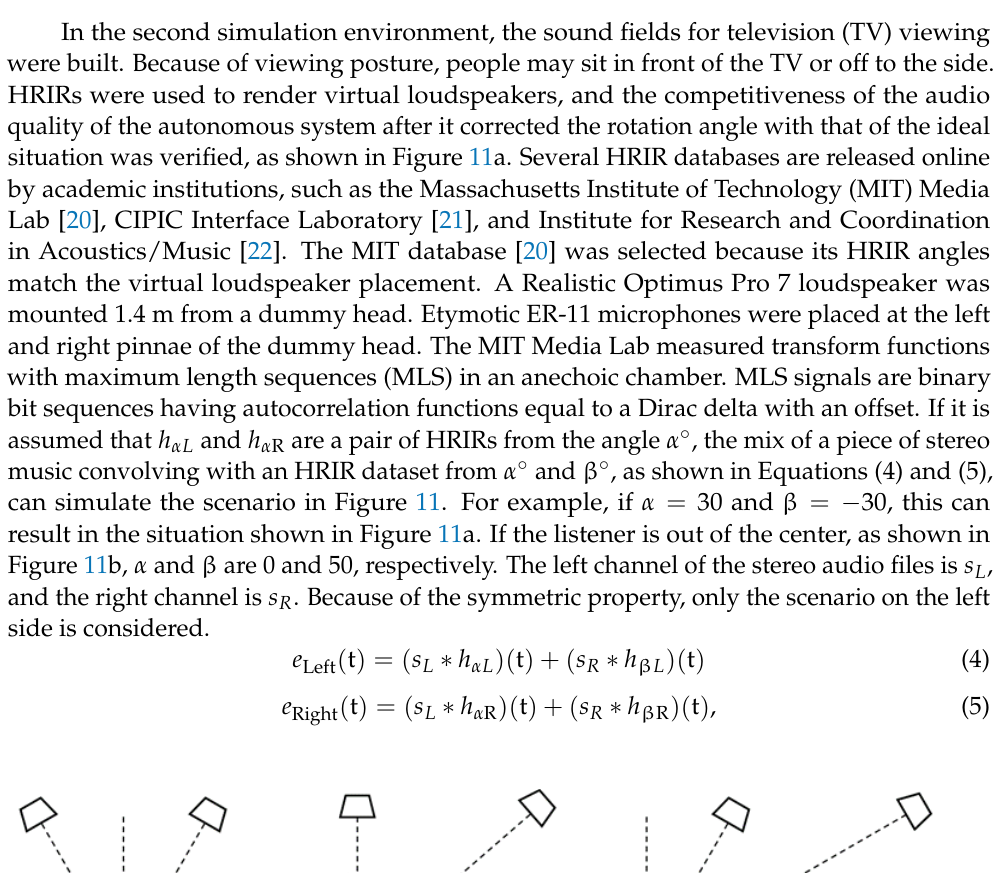
Figure 10. Head-related transfer functions (HRTFs) from angles 0° and 180° .